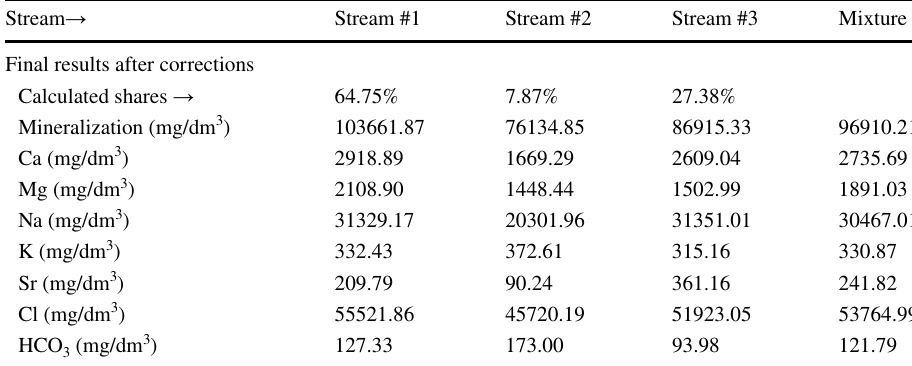
Table 3 Final balance of water system (level 700, Year 2) obtained with KYBL 7 software ‑ methods CHM1+MRC1